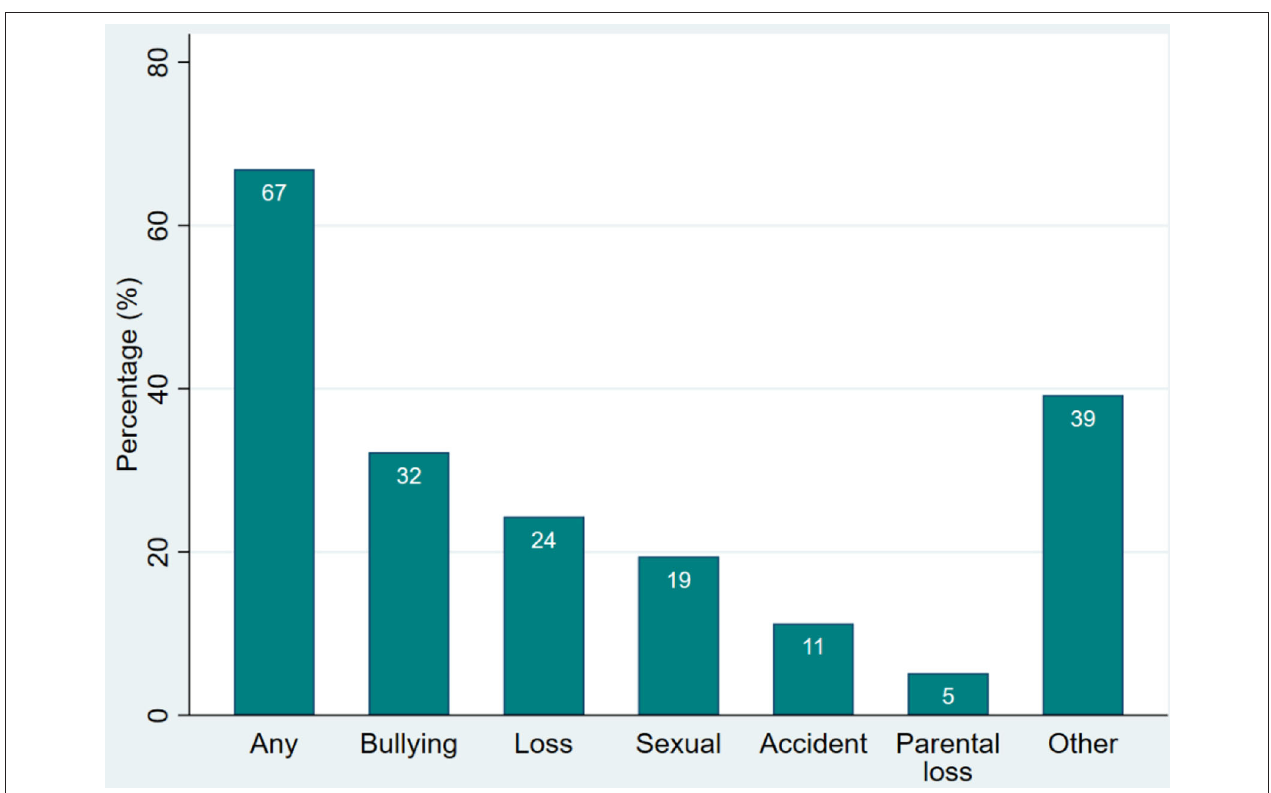
FIGURE 2 | Types of TE reported by the patients. Percentage of patients ( N = 329) with ED who have experienced each type of TE.